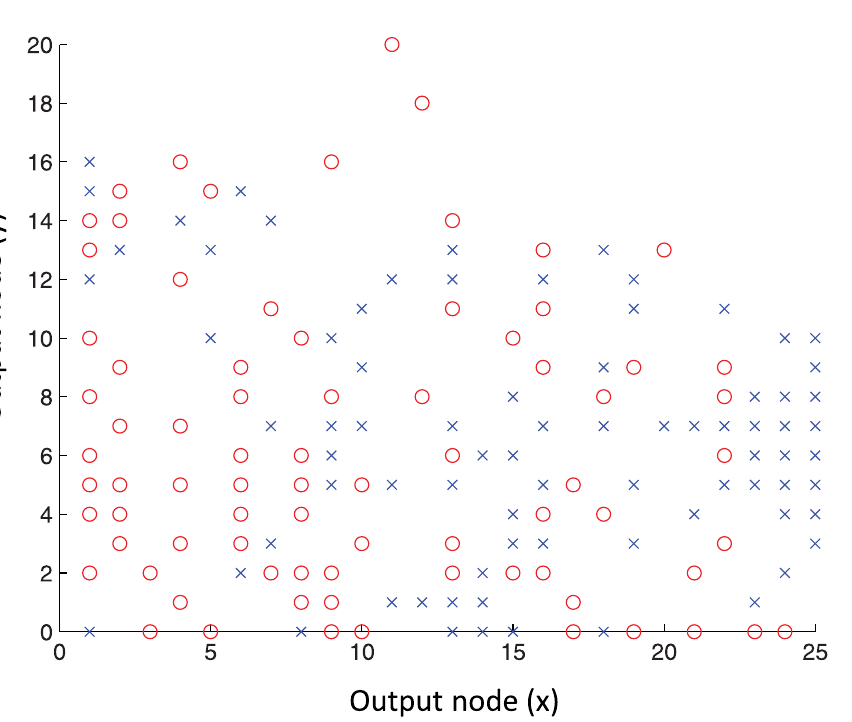
Fig 6. Self-organizing map, trained using the movement patterns of participants under complex exergaming task conditions. Self-organizing map (SOM) trained using the x and y coordinates of consecutive best matching units (BMU) on the first SOM for the trials where young and older adults differed significantly in TTvar. Trajectories of trials of young and older adults were presented to the trained SOM as a single input vector containing all ten sways performed in that trial. The BMU ’ s matching the trajectories of young (blue x) and older adults (red o) are not spread homogeneously on the map; the lower left corner constitutes of predominantly older adults, whereas many of the trials performed by young adults are organized on the right side of the map.